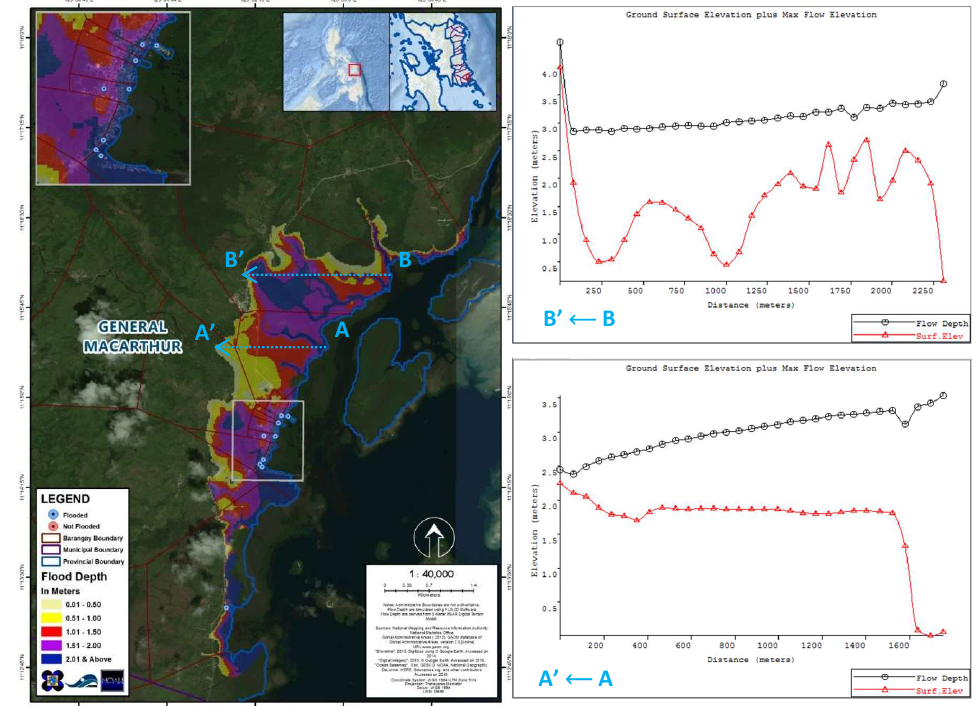
Figure 9. Storm surge inundation (left panel) and cross-sectional x height elevation (red line in right panel); storm surge flooding (black line) in terms of elevation for transects A to A′ and B to B′ (blue solid lines in the left panel,) showing effect of elevation on storm surge height.